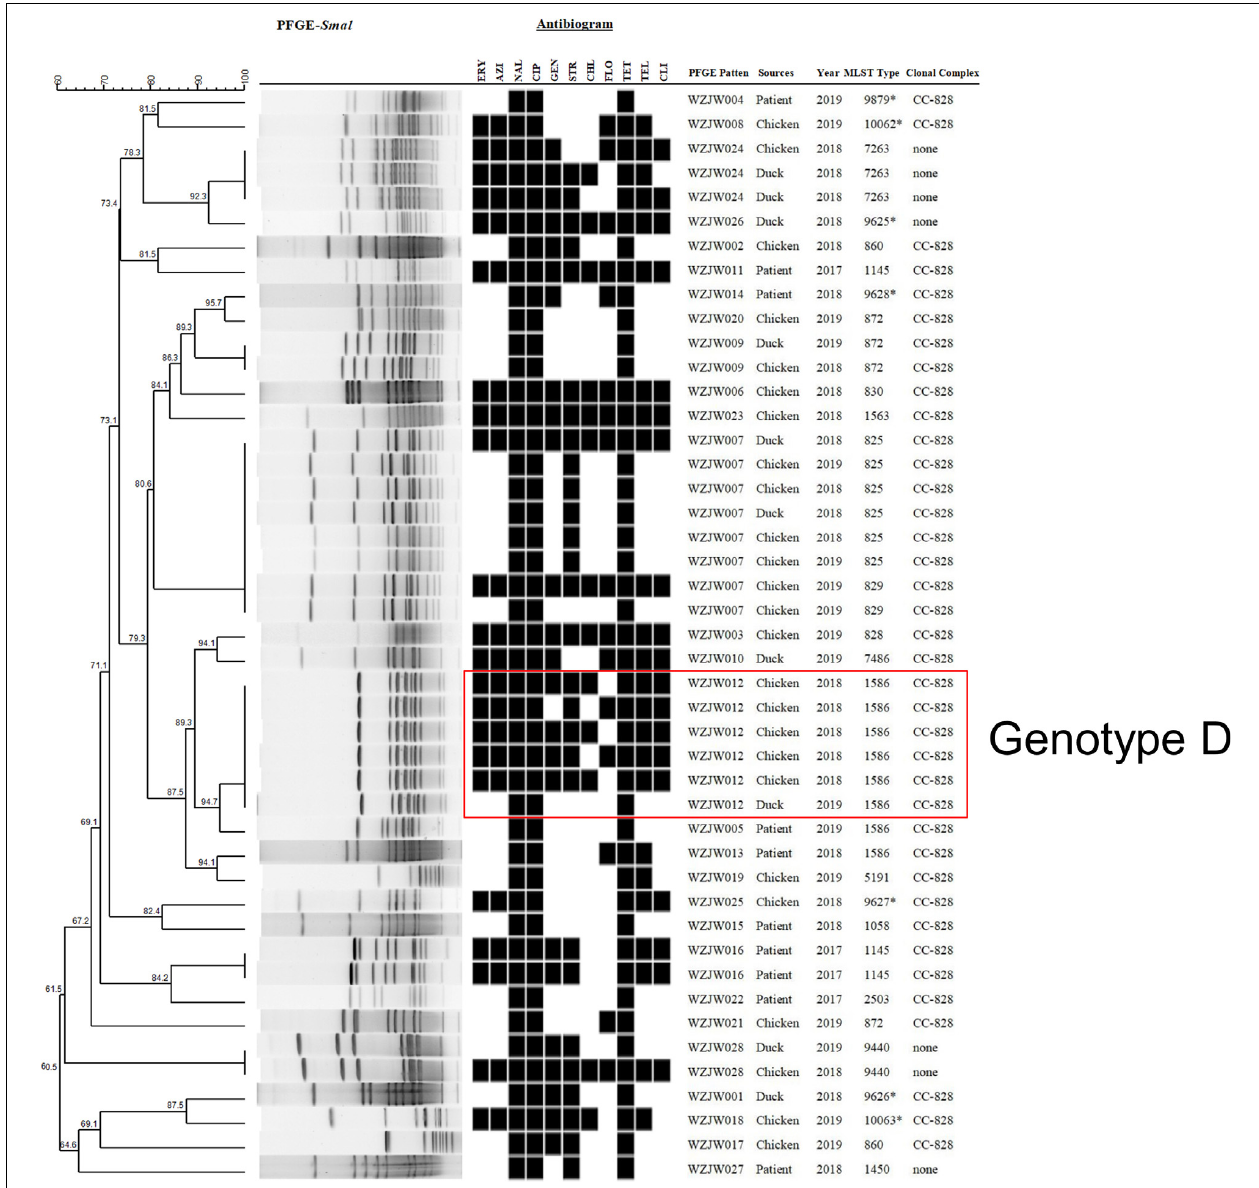
FIGURE 3 | Dendrogram of 45 C. coli strains based on Sma I-mediated PFGE profiles. PFGE pattern, strain source, isolation year, sequence type, and clonal complex are depicted. Asterisk indicates newly designated ST in this study. Black squares in the antibiogram indicate resistance to